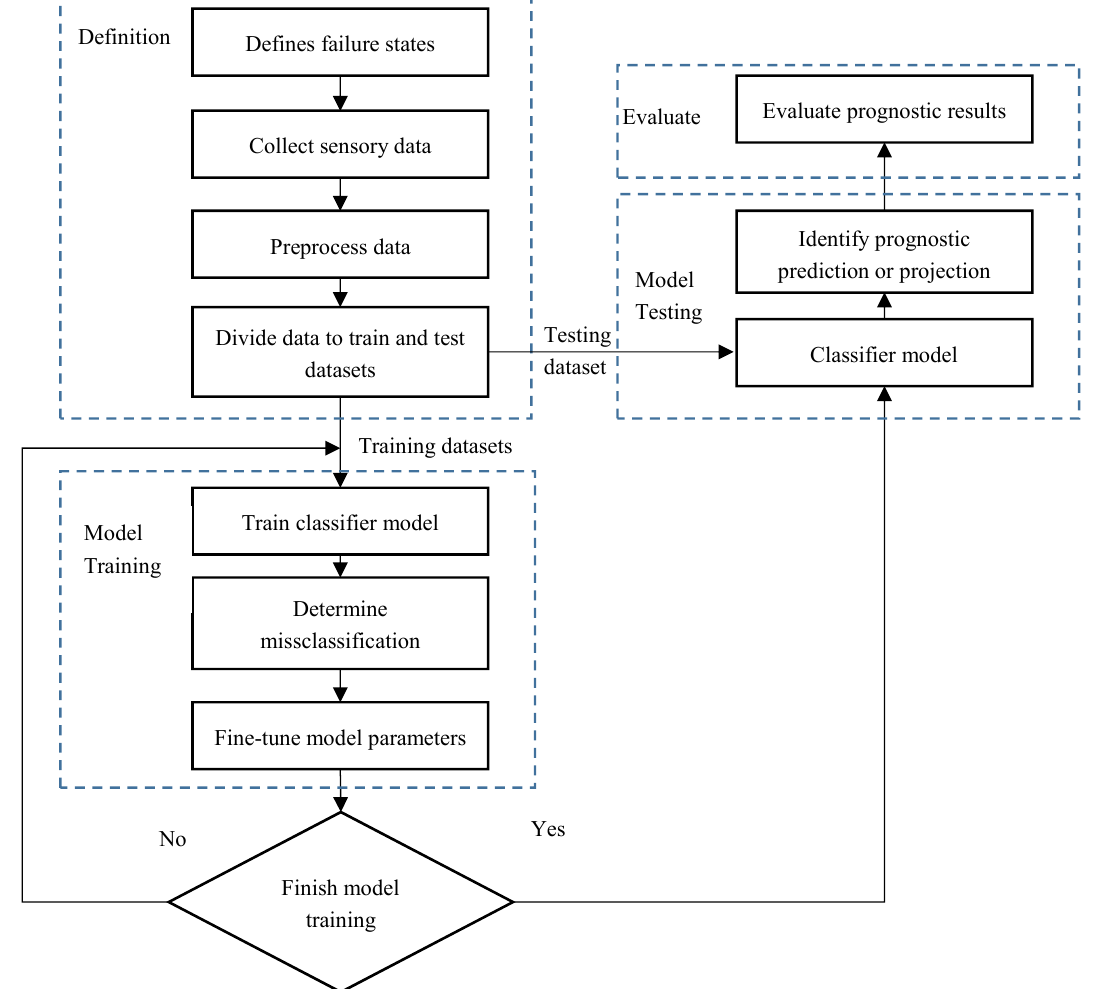
Figure 4. The process of a prognostic framework using deep learning.